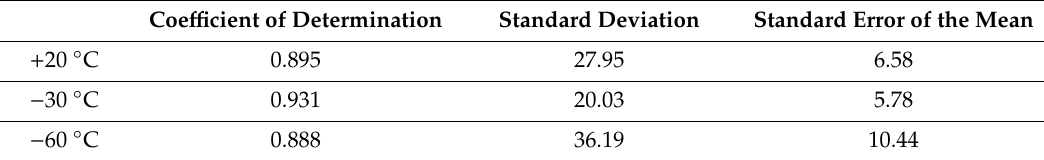
Table 3. Statistical analysis of the S–N